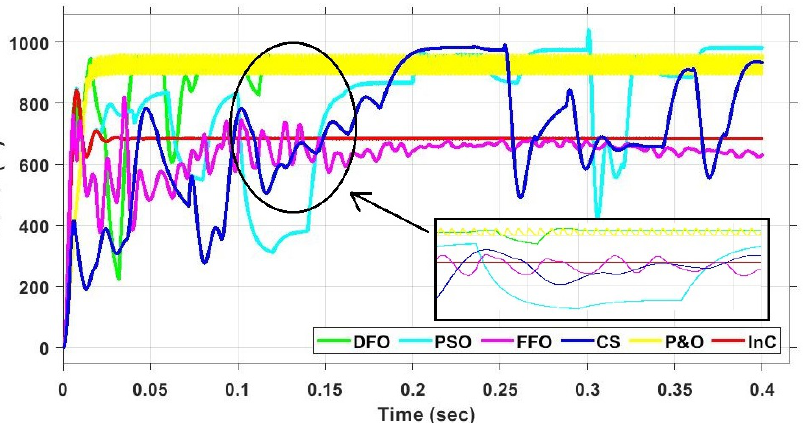
Figure 34. UI power comparison between all algorithms for MLPE Distributed PV system.